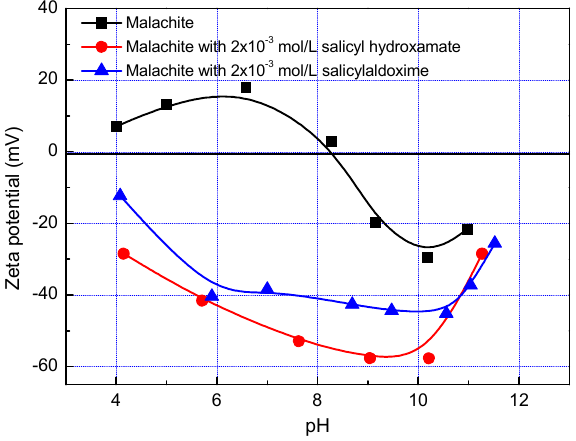
Figure 3. Effect of salicyl hydroxamate and salicylaldoxime on the zeta potential of malachite as a function of pH.